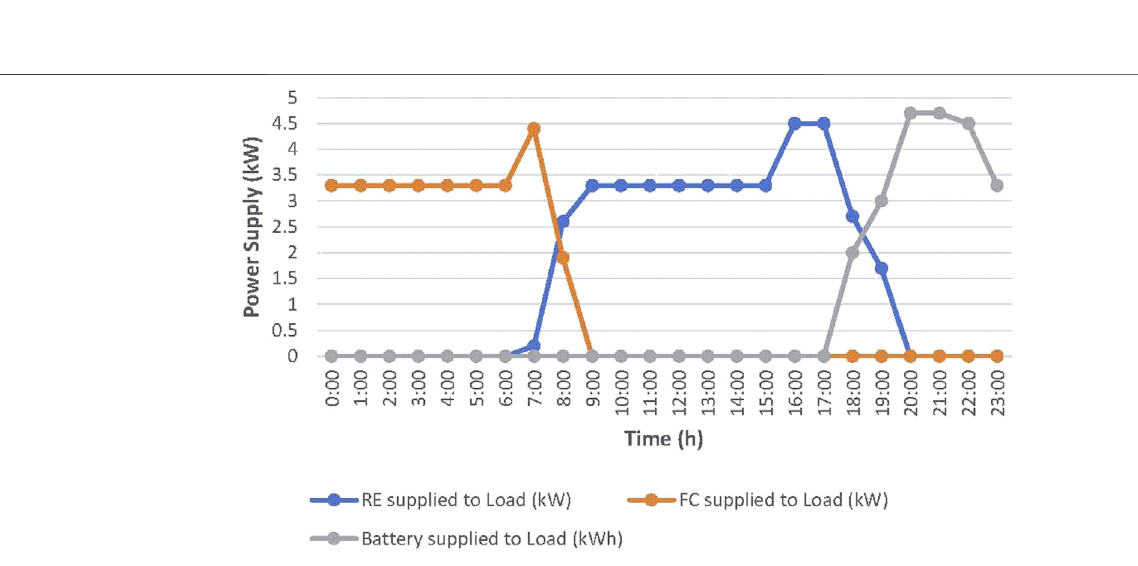
Frontiers in Energy Research |